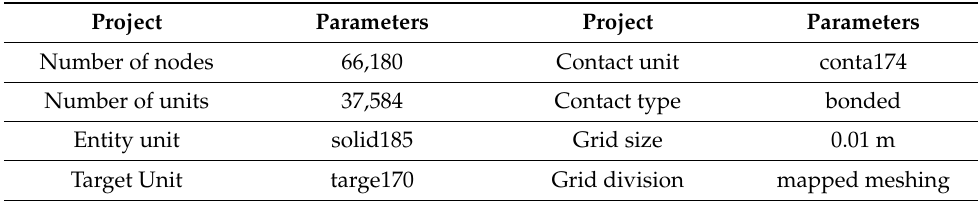
Table 2. Parameters of finite element model.